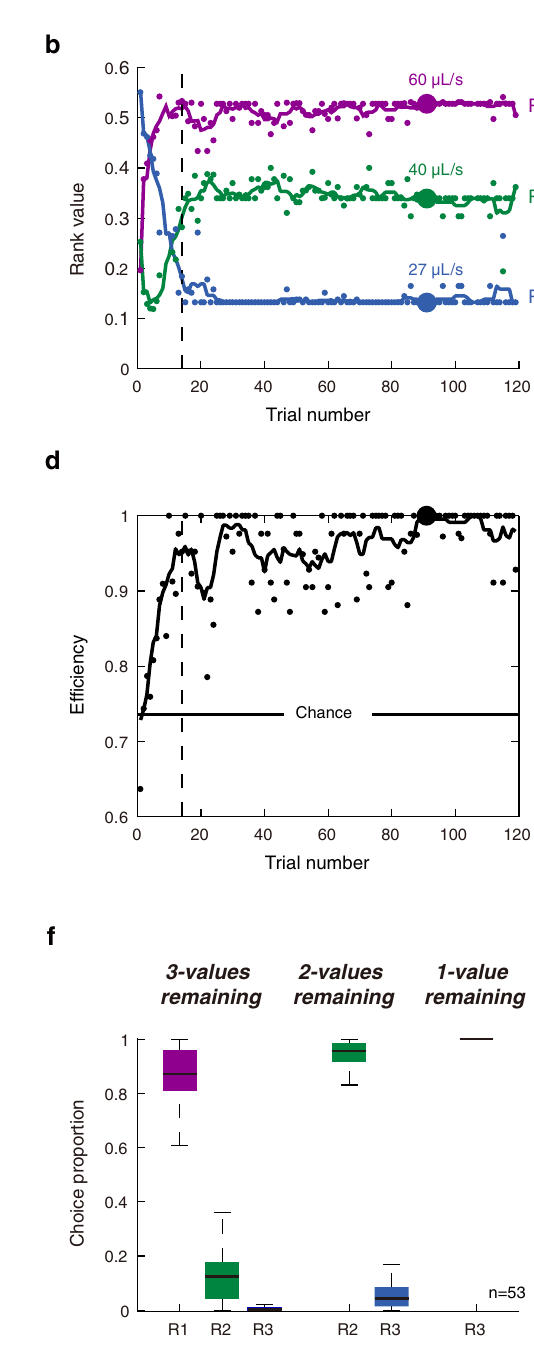
menu, the choice-in neuronal activity associated with each value ranking reached a common level during the late period of fi xation (Fig. 5b; n-way ANOVA test, effect of value, F 2,250 = 0.31, P = 0.73; see Supplementary Fig. 4a, b for individual monkey data).